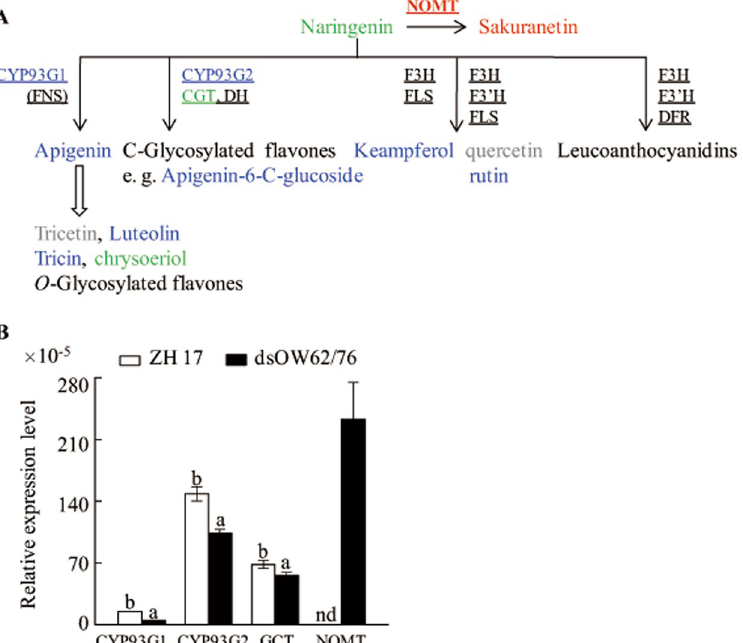
Figure 3. Changes in the flavonoid biosynthesis ( A ) and expression of the related genes ( B ) in dsOW62/76 and ZH17 plants. Naringenin is a common substrate for flavonoid biosynthesis. The font colors and shapes represent the same meanings as described in Fig. 1. A rice ubiquitin gene was used as the internal standard for qPCR analysis. Experiments were performed twice with similar results. Values marked with different letters indicate statistically significant differences as analyzed by SAS software (Duncan’s multiple range test, α = 0.05). nd for not detected. Abbreviations: CGT, C -glucosyltransferase; CYP93G1, P450 flavone synthase; CYP93G2, P450 flavanone 2-hydroxylase; DH, dehydratase; DRF dihydroflavonol 4-reductase; F3H, flavanone 3-hydroxylase; F3 ′ H, flavanoid 3 ′ -hydroxylase; FLS, flavonol synthase; FNS, flavone synthase; NOMT, naringenin 7- O -